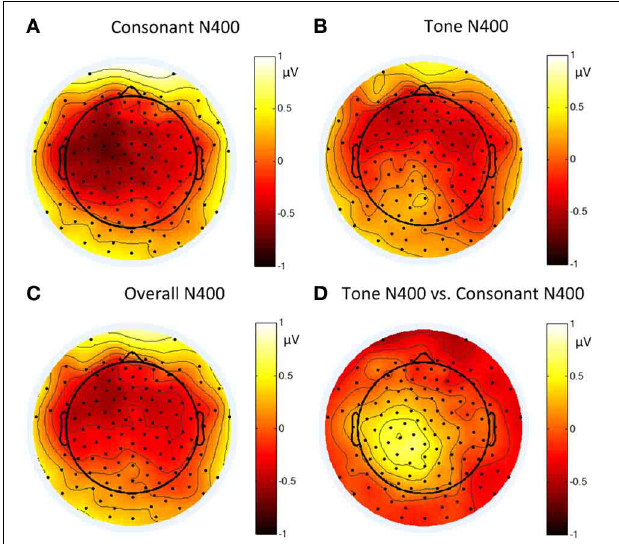
FIGURE 13 | Topographies of: (A) the N400 induced by consonant violation; (B) the N400 induced by tone violation; (C) the N400 induced by summing up consonant and tone violation; and (D) the difference between the N400 in (B) and (A) in Experiment 3.